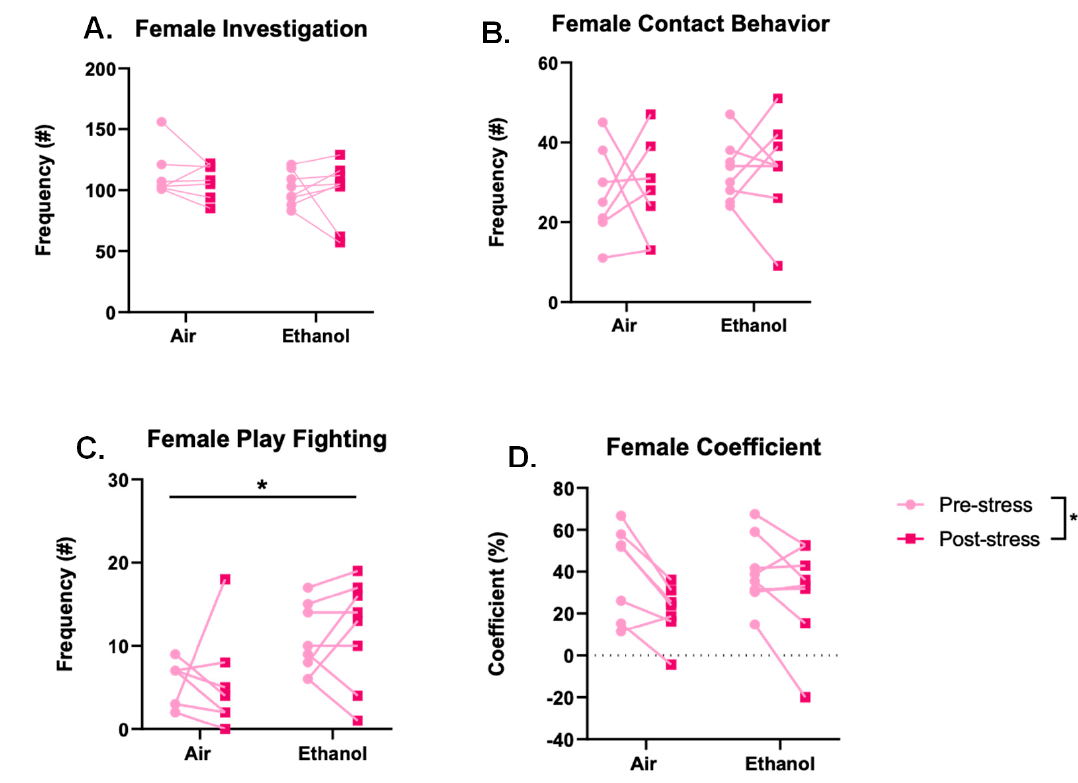
Figure 5. Frequencies of female social interaction behaviors, namely investigation ( A ), contact behaviors ( B ), play-fighting behaviors ( C ), and social preference / avoidance coefficient ( D ), compared between adolescent ethanol or air exposure and 24 h before and after two days of forced swim stress. Ethanol-exposed females showed increased play-fighting behavior, and females showed a lower preference / avoidance coefficient following stress. Significant main effects denoted as * p < 0.05 and ** p <